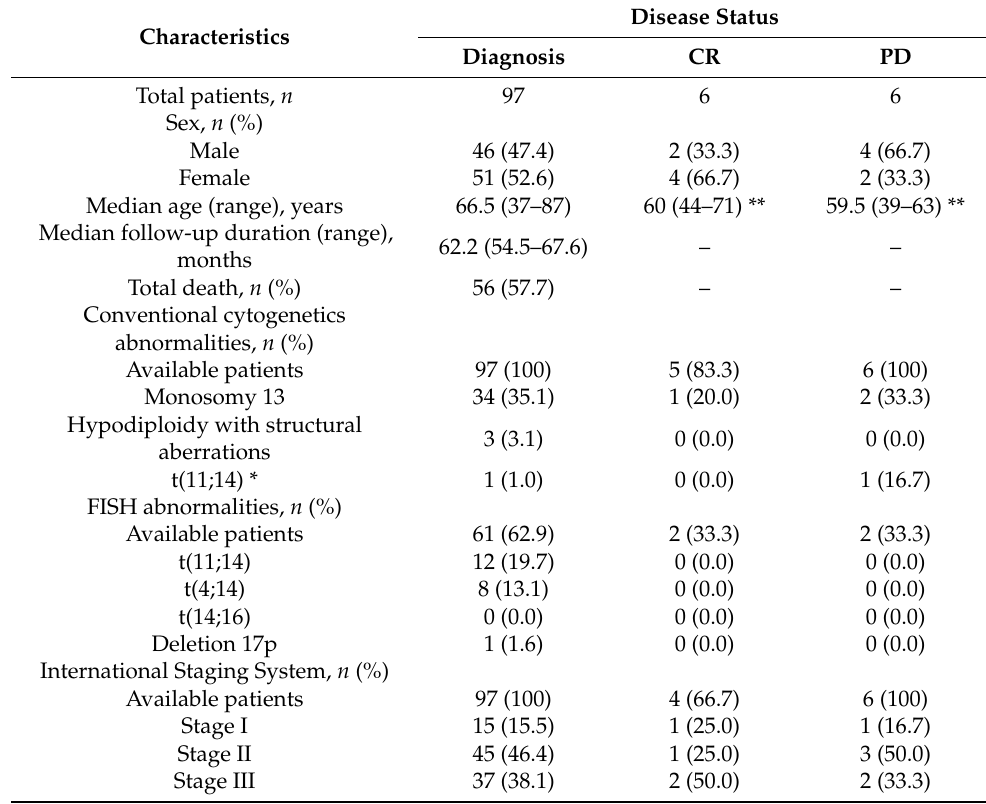
Table 1. Clinical and cytogenetic findings of 109 patients with plasma cell